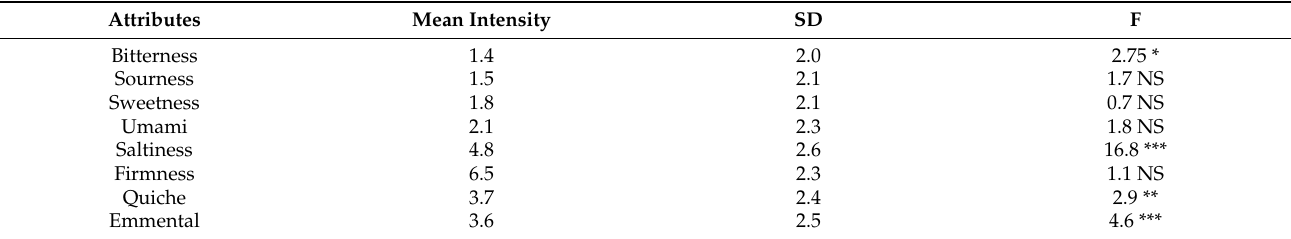
Figure 2. Principal component analysis (PCA) biplots (PC1,2 ( A ) and PC1,3 ( B )) of the 8 attributes (taste, flavour, and texture attributes) rated during the descriptive analysis session for 7 four-layer cream-based products with 54 panellists. S H and A H : homogeneous distribution of salt and aroma, respectively. S n and A n : heterogeneous distribution of salt and aroma in layer n, respectively. S H +: contains 35% more salt than S H . Table 1. Mean intensity (standard deviation: SD), as well as panel discrimination among the 7 FLPs for each of the 8 attributes evaluated by descriptive analysis performed by 54 panellists. According to the F-ratio of the product factor ANOVA (Fisher statistics): *, **, and *** indicate a significant product effect at p < 0.05, p < 0.01, and p < 0.001, respectively, and NS indicates a nonsignificant product